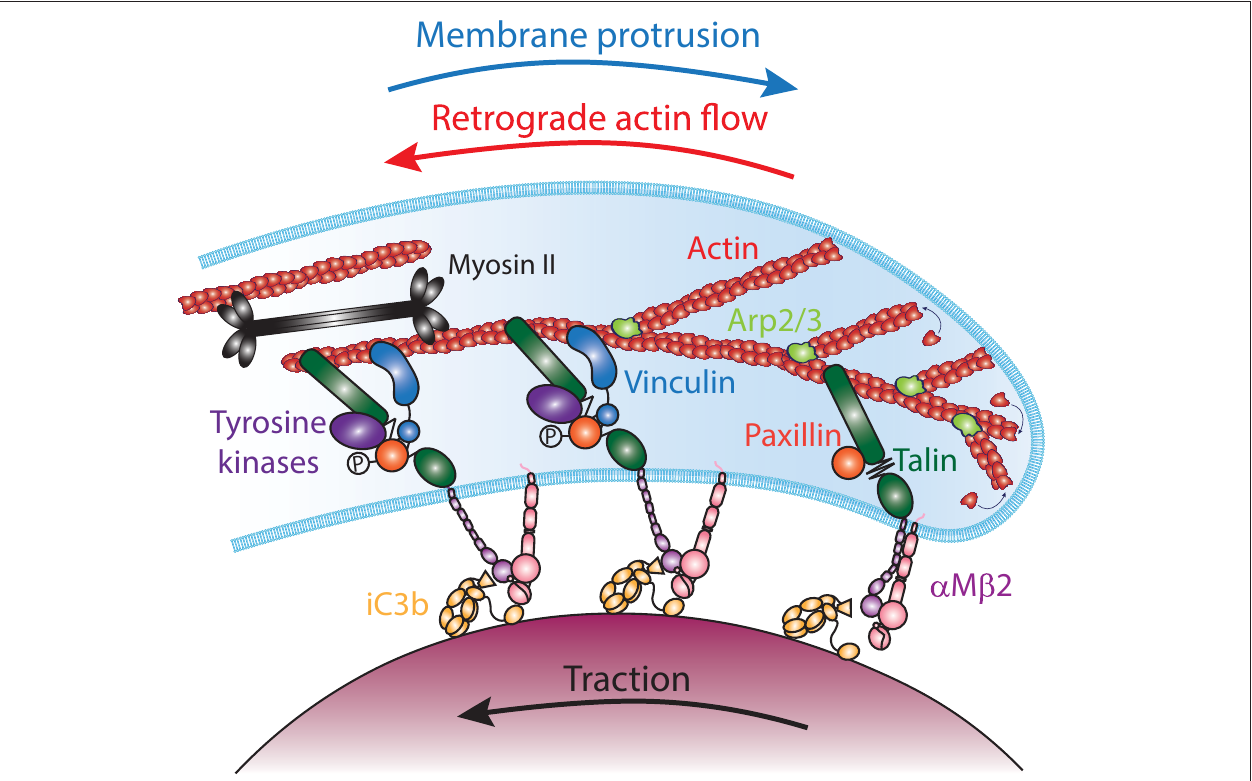
FIGURE 6 | The molecular clutch model in α M β 2-mediated phagocytosis. The Arp2/3 complex (light green) nucleates actin (red) polymerization at the leading edge of the phagocytic cup. The addition of new monomers to the filaments at the membrane generates forces that push against the plasma membrane, leading to an equilibrium between membrane protrusion and the retrograde flow of actin filaments. Coupling of iC3b (yellow) -bound α M β 2 integrins (purple and pink) to actin filaments by Talin (dark green), transmits mechanical tension that switches the integrins into an extended-open conformation and provides traction on the particle. Stretching of Talin reveal Vinculin (blue) binding sites and the phosphorylation of Paxillin (orange) by tyrosine kinases (purples). This leads to the recruitment of Vinculin, which reinforces the molecular clutch to prevent its slippage, reducing the retrograde flow of actin and increasing traction and forward protrusion. In addition, contractility mediated by Myosin II (black) could increase tension across Talin and increase the actin retrograde flow and traction onto the particle, while reducing the protrusion of the phagocytic cup